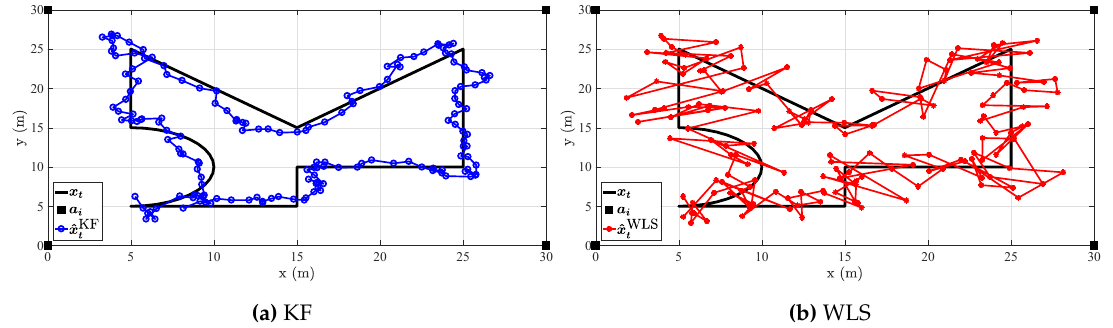
Figure 4. Illustration of the estimation process in a single M c run, when N = 4, |L NLOS | = 4, σ i = 3 (dB, m), bias max = 5 (dB, m), bias i ∼ U [ 0,bias max ] , B = 30